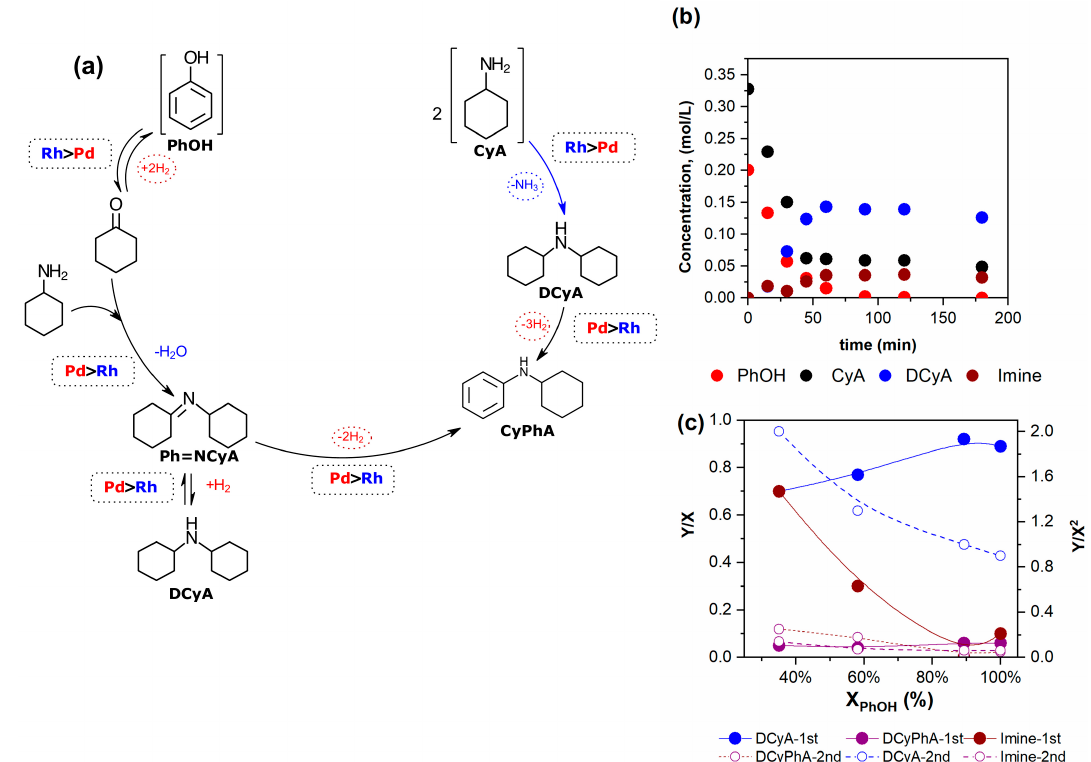
Figure 4. ( a ) Summarized reaction pathway for the reaction of phenol with cyclohexylamine to secondary amines over Pd/C and Rh/C. Those reaction steps enhanced by Pd or Rh are properly indicated in colors ( b ) temporal concentration profiles for phenol amination over Rh/C and ( c ) DelPlots of phenol amination over Rh/C.